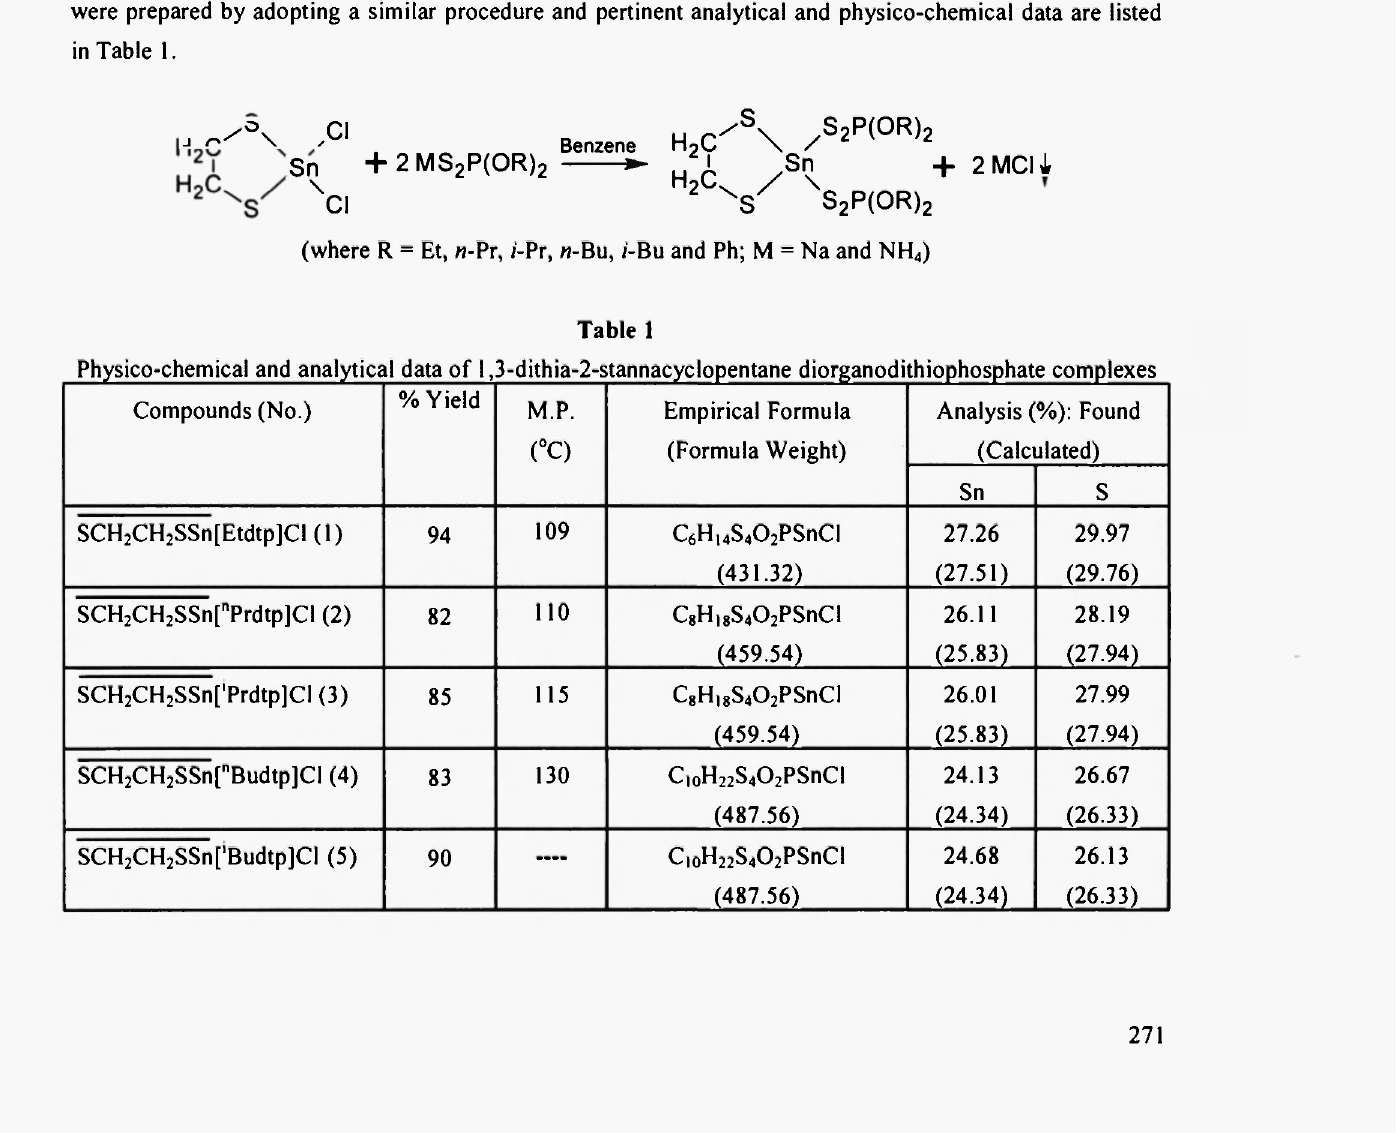
Physico-chemical and analytical data of l,3-dithia-2-stannacyclopentane diorganodithiophosphate complexes % Yield Compounds (No.) Empirical Formula Analysis (%): Found (Formula Weight)